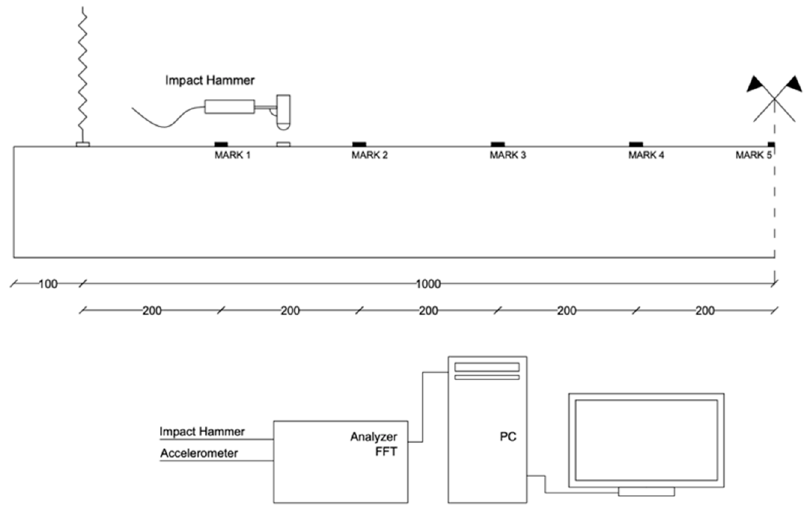
Figure 6. Setup of vibration